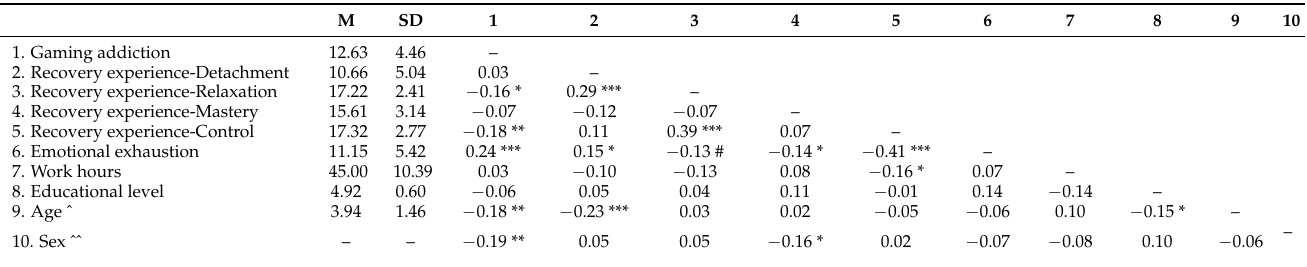
Table 1. Descriptive statistics and correlations among variables (N =